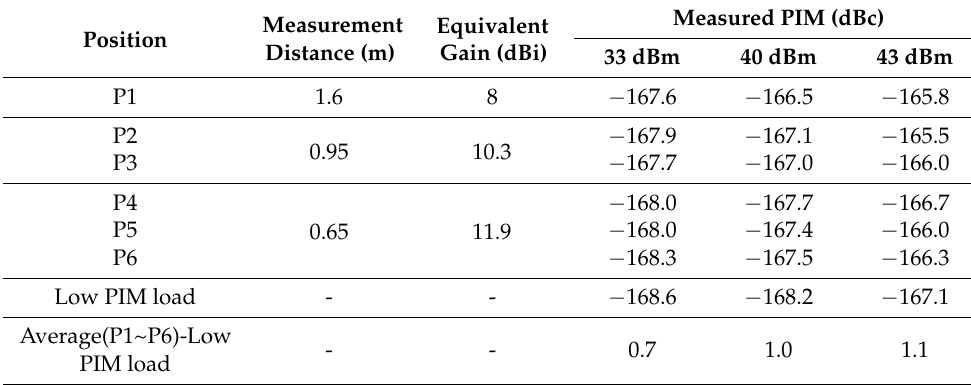
Table 4. Measured results of chamber B at 1730